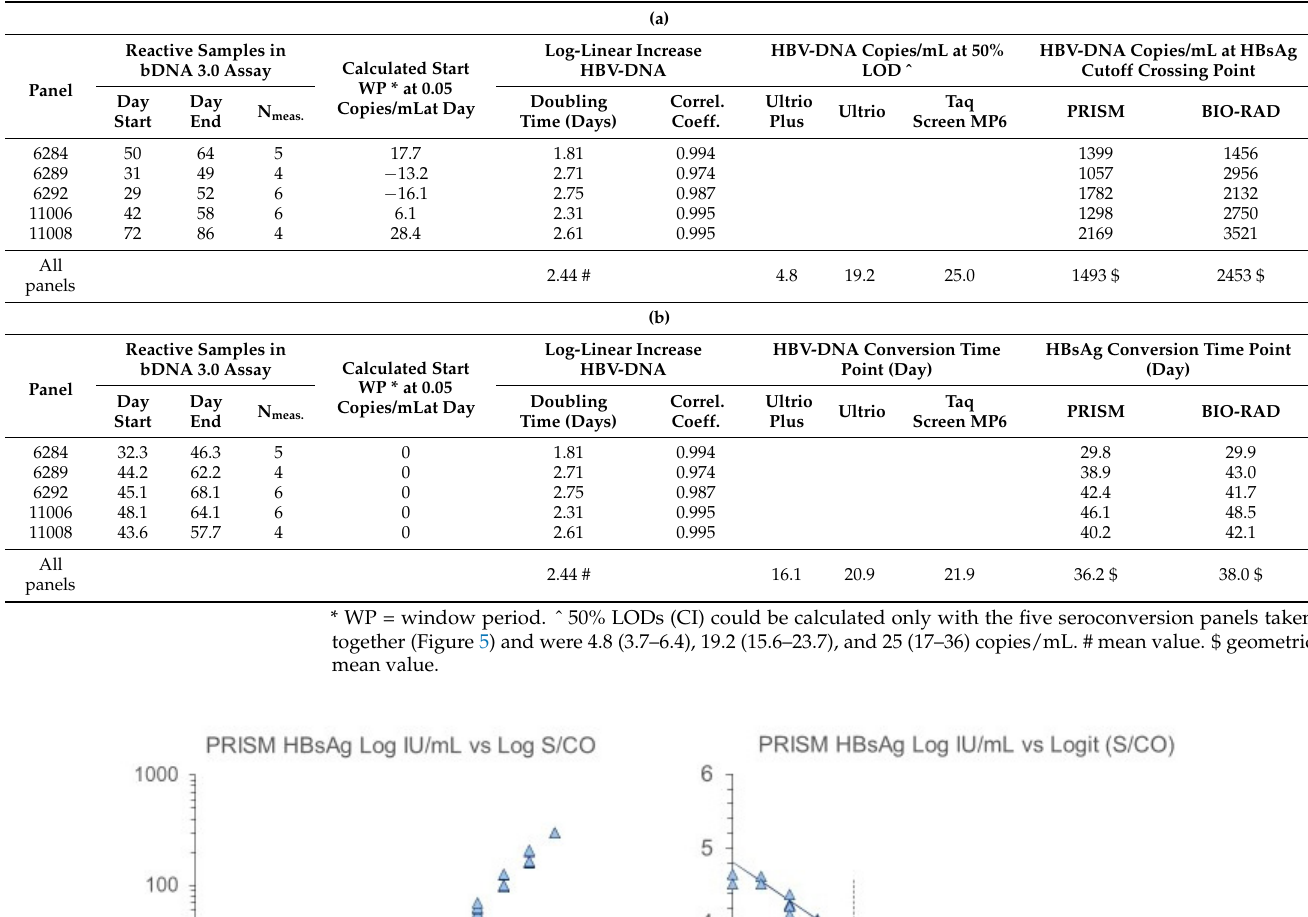
Table 1. Regression analysis parameters for exponential (Log-linear) increase of HBV-DNA and HBsAg concentration over time in five seroconversion panels based on given sampling times in Zep- tometrix data sheet (upper ( a )) and when time points are adjusted arbitrarily to a start of the infectious